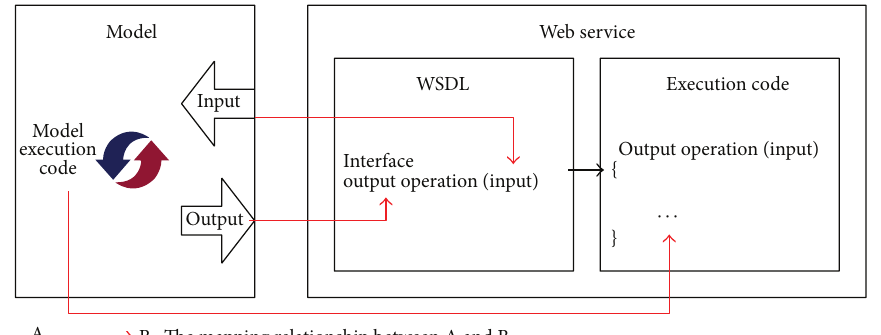
Figure 3: Mapping a model to a Web